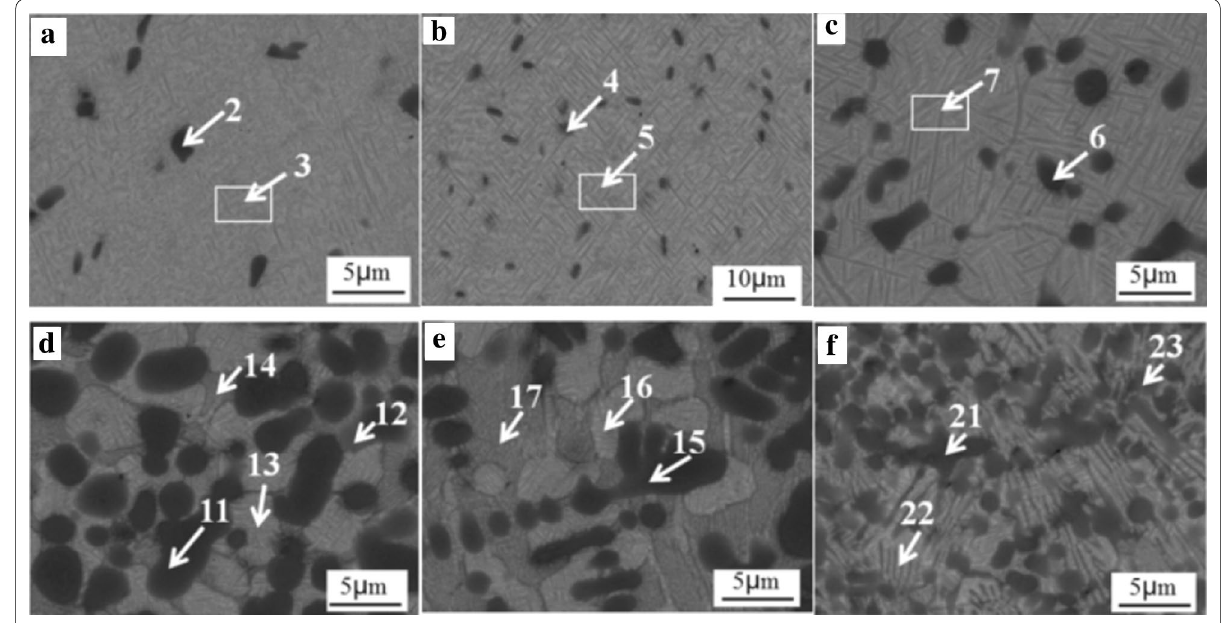
Figure 9 The BEIs of typical different TMCs: a 10%TiSiC, b 30%TiSiC, c 50%TiSiC, d 70%TiSiC, e 80%TiSiC, f 100%TiSiC